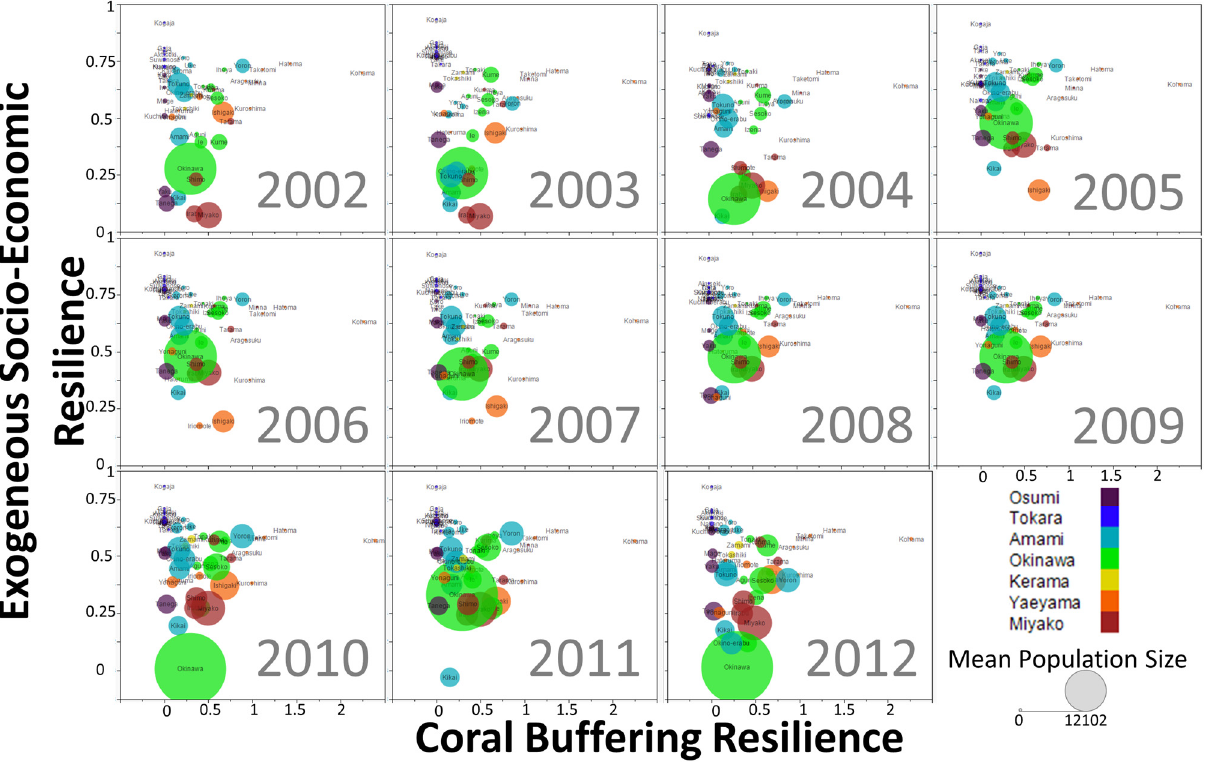
Figure 7. Island-scale bubble plots of the exogenous socioeconomic resilience with the coral buffering resilience. The bubble size represents the mean population, and the colors represent the Nansei sub-archipelagoes during